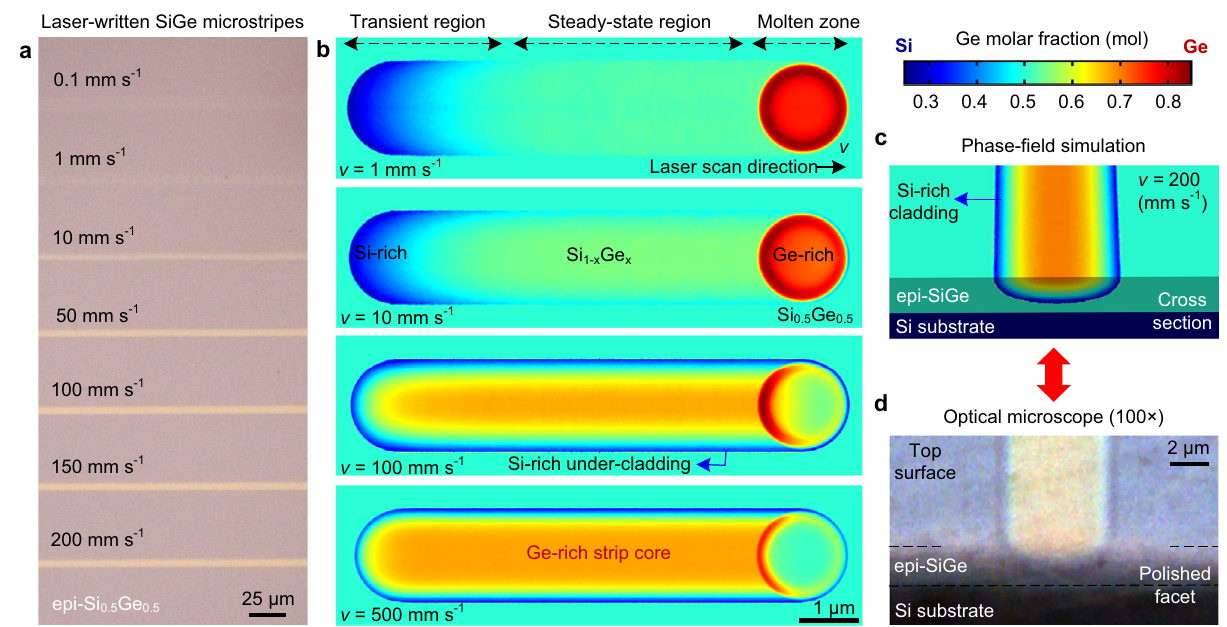
Fig. 1 Laser writing of in-plane longitudinal SiGe heterostructures via scan-speed-dependent spatial redistribution of the composition. a Optical microscope image showing laser-written microstripes on a Si 0.5 Ge 0.5 thin fi lm (epi-SiGe) epitaxially grown on Si substrates, for scan speeds in the range of 0.1 – 200 mm s -1 . b Results of fi nite-element-method (FEM)-based phase- fi eld simulations for laser-driven phase segregation are given as composition color maps showing the Ge molar fraction x ( r ) for the short transient (blue) and inde fi nitely-long steady-state regions (yellow/orange) solidi fi ed behind the laser-induced molten zone (red) traveling at a constant scan speed in the range of 1 – 500 mm s − 1 . c Simulated spatial redistribution of the alloy composition in the cross-section and on the top surface of a laser-written microstripe. An in-plane longitudinal SiGe heterostructure was formed with a Ge-rich strip core and Si-rich under-cladding along the scan direction. The image size in the transverse direction was rescaled accordingly to match the width of the laser-written microstripe in d . d Optical microscope image showing the angle-polished cross-section and top facet of a longitudinal SiGe heterostructure laser-written at 200 mm s − 1 for qualitative comparison with the simulation